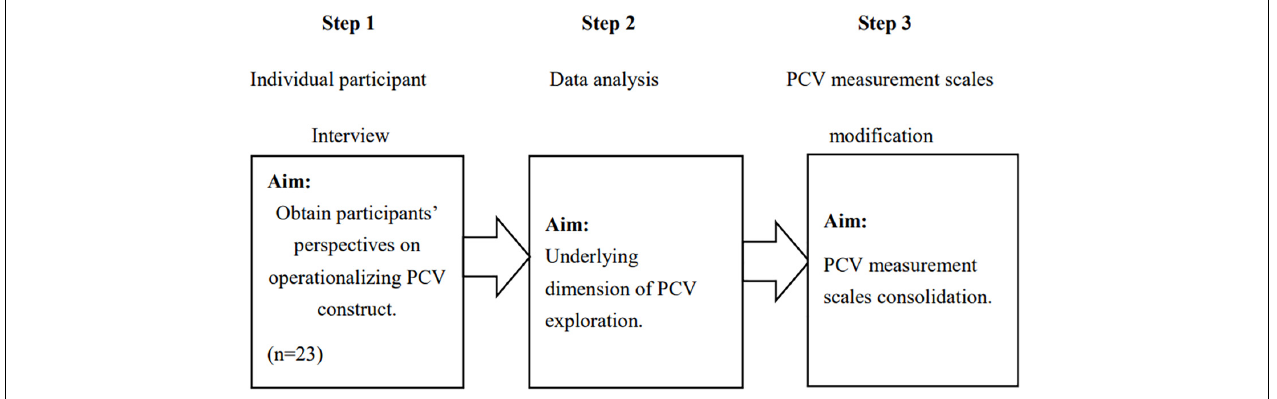
FIGURE 1 | Procedures of qualitative research ( n = 23). PCV, perceived co-creation values.